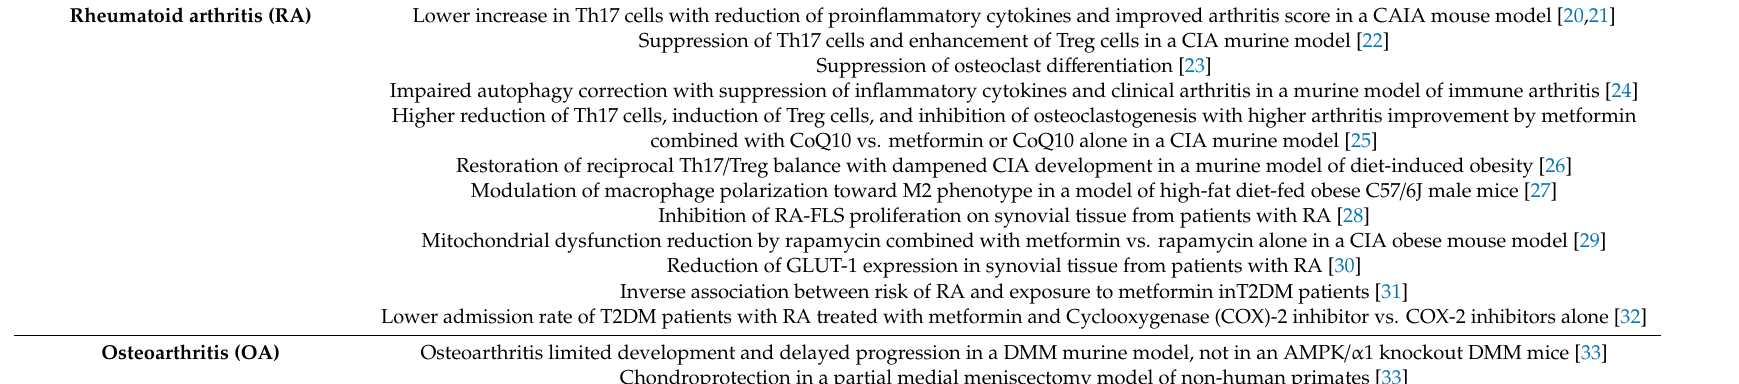
Table 1. Experimental and clinical e ff ects of metformin in rheumatologic autoimmune and inflammatory conditions. Rheumatoid arthritis